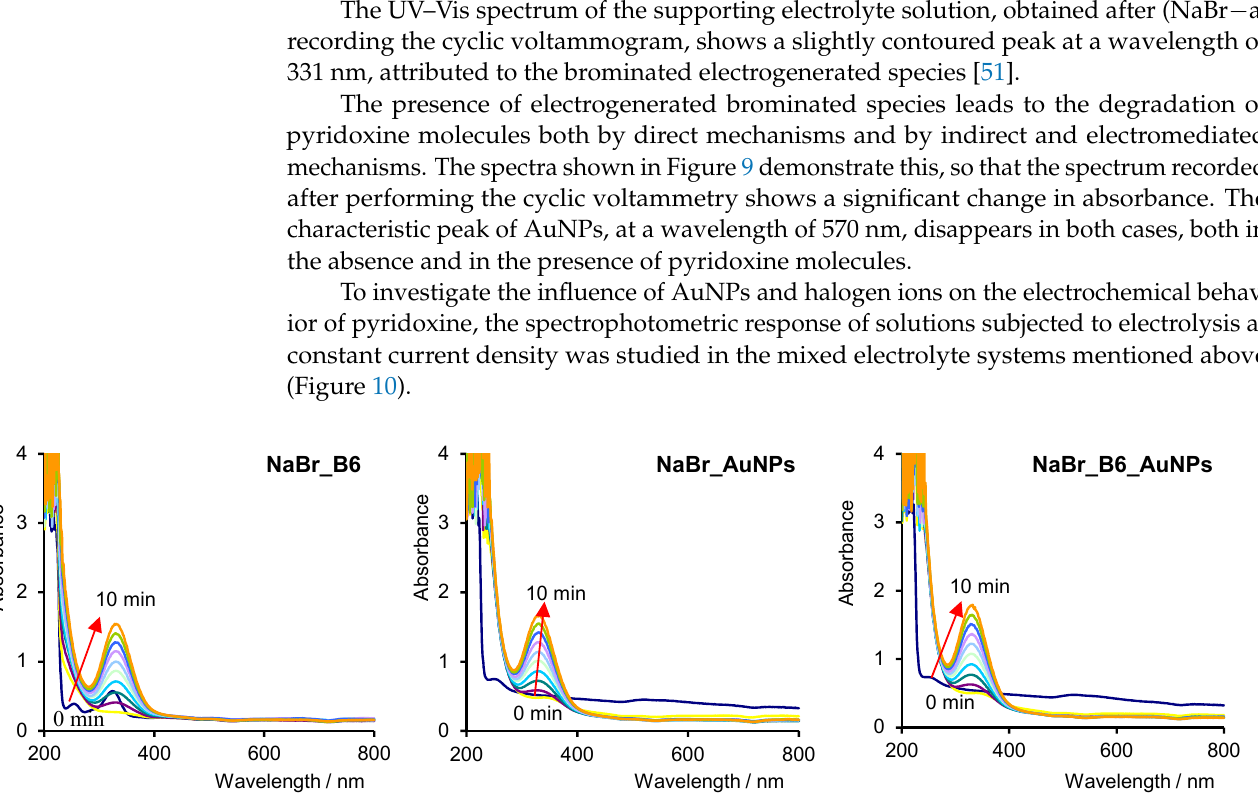
Figure 10. UV–Vis absorption spectra of sample as the electrochemical processes progress over time in NaBr/B 6 /AuNP systems (i = 50 mA × cm − 2 ).